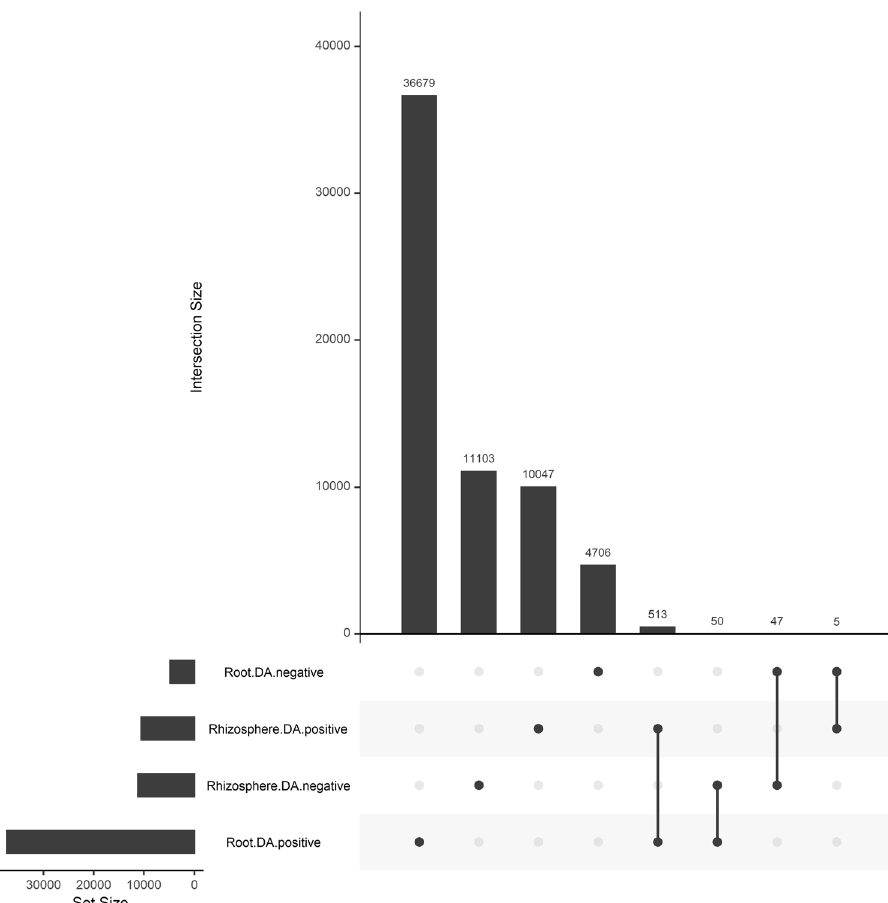
Fig. 6 Shared and unique transcripts. Upset plot showing the shared and unique transcripts between the root and rhizosphere transcripts positively (DA + ) or negatively (DA-) differentially